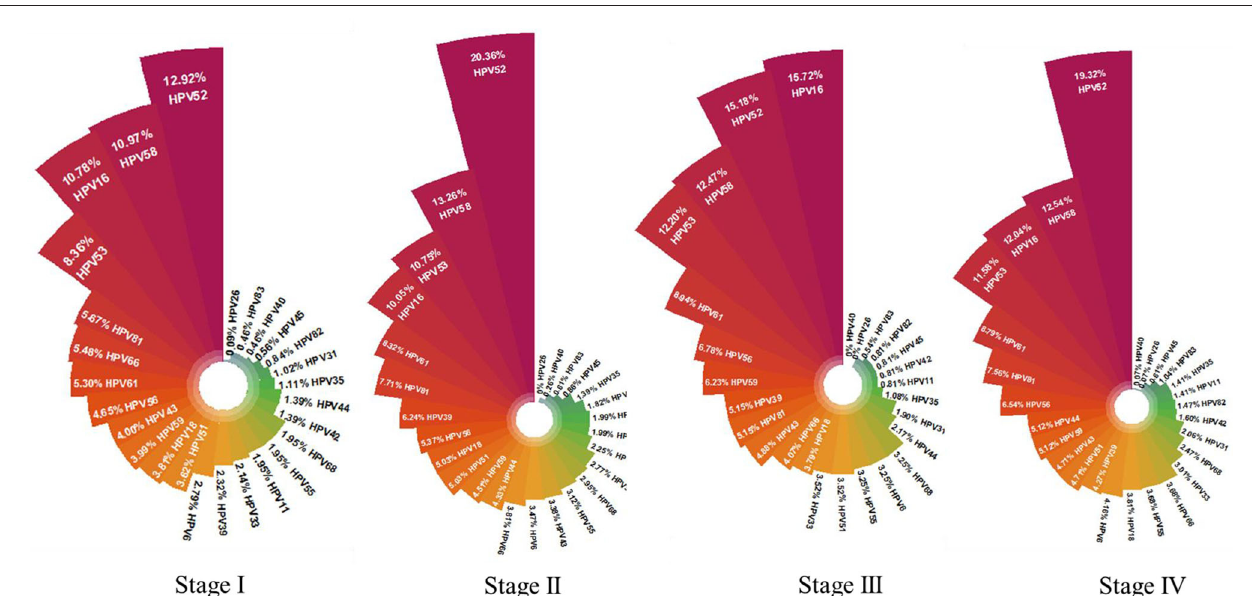
FIGURE 6 | Prevalence and composition of HPV genotype in different stages. Stage I: Baseline in the same period last year before the SARS-CoV-2 outbreak; Stage II: Before SARS-CoV-2 outbreak; Stage III: During the prevalence of SARS-CoV-2; Stage IV: After the SARS-CoV-2